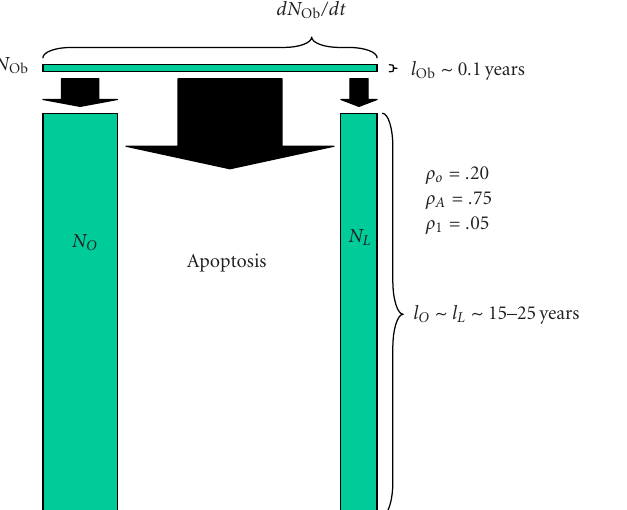
Figure 7. Transit cell populations downstream of the osteoblast. The three di ff erentiation pathways available to osteoblasts and the two transit populations downstream of the osteoblast are illustrated, using the same illustration strategy described in Figure 6. Probability values that would be common in cortical osteonal bone remodeling are